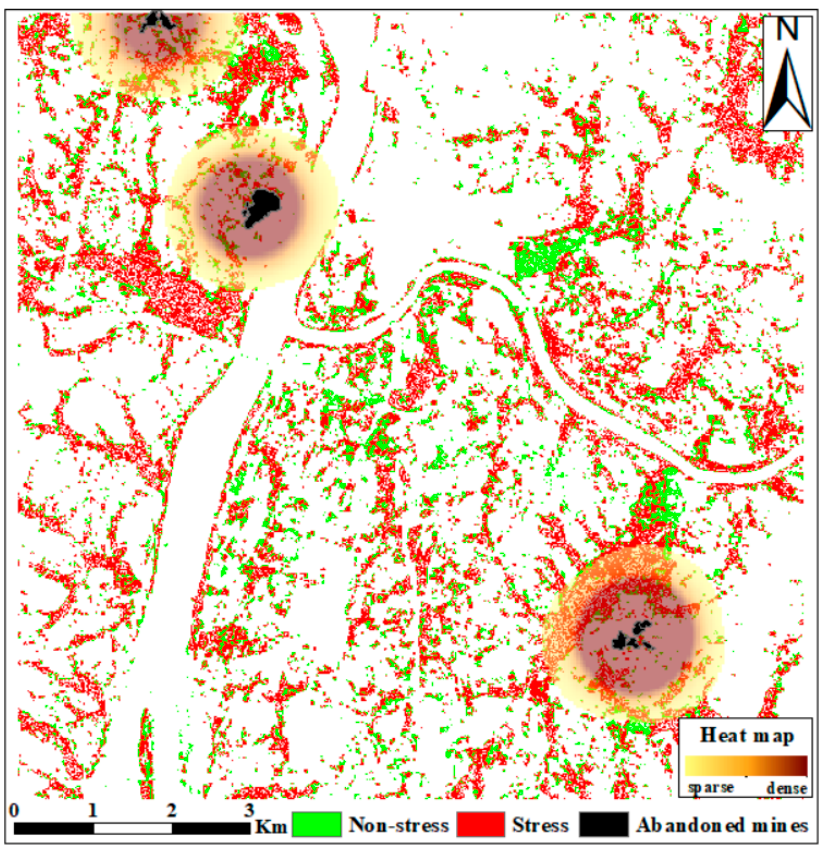
Figure 9. Distribution and heat map of abandoned mines in Zhuzhou.